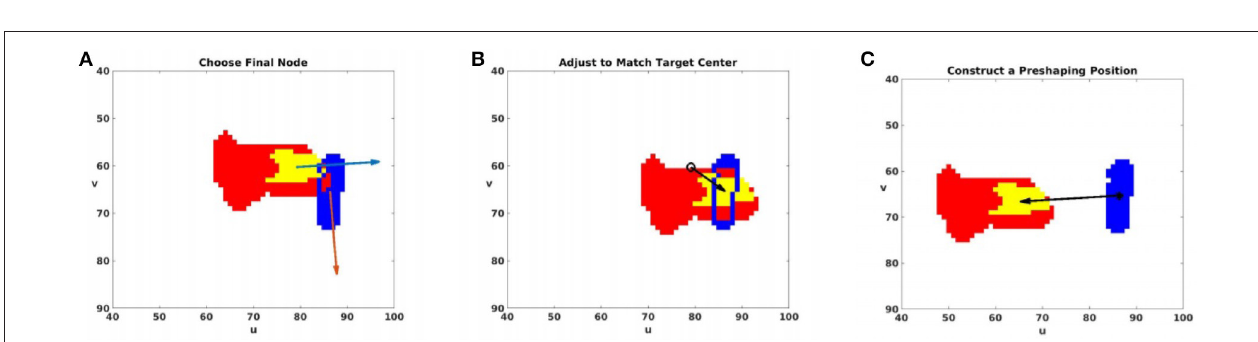
FIGURE 9 | The portion of attempted reach trajectories that produce observed bumps (orange), ground truth bumps (yellow), and Palmar bumps, or bumps which also trigger the Palmar reflex (purple) for varying gripper apertures a . The high reliability of the reach action is independent of a , indicating it could be learned and executed with any setting. By contrast, triggering the Palmar reflex is much more likely as a increases, and is learned as a prerequisite for the Palmar bump event and later for the grasp action.